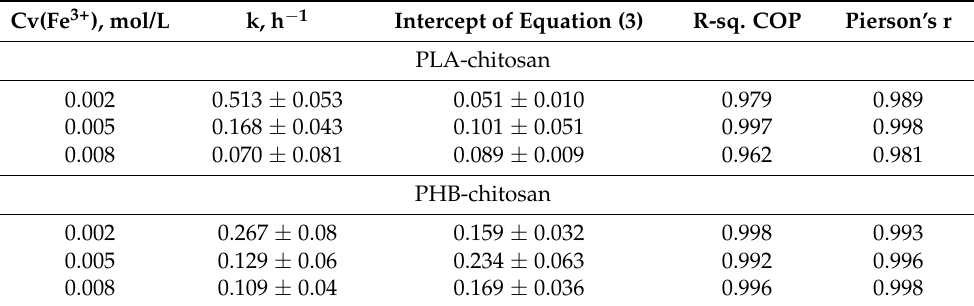
Figure 5. Kinetic curves of Fe 3+ ions sorption by PLA—chitosan ( a ) and PHB—chitosan ( b ) in semi-logarithmic coordinates. Sorption was performed from FeCl 3 aquatic solutions with different concentrations 0.002 (1), 0.005 (2), 0.008 (3) mol/L. Table 1. Parameters of Fe 3+ sorption by binary composite films PLA-chitosan and PHB-chitosan (50:50 wt.